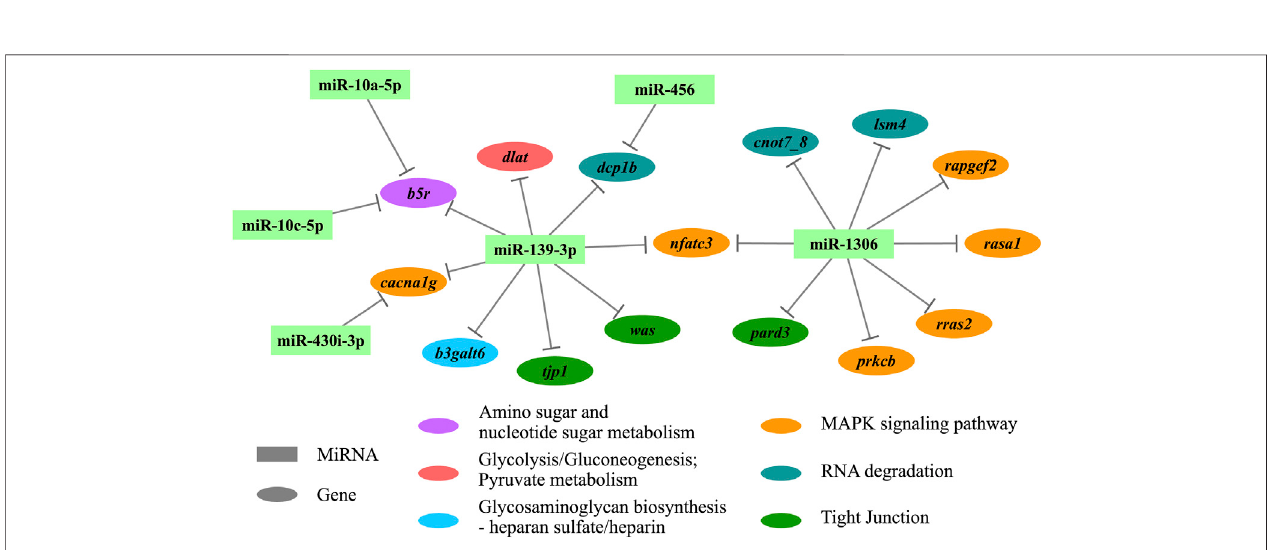
FIGURE 5 | Thehub network ofdifferentiallyexpressed miRNAs(DEMs)and their KEGGenrichedtargetgenes.KEGG, Kyoto EncyclopediaofGenes and Genomes.